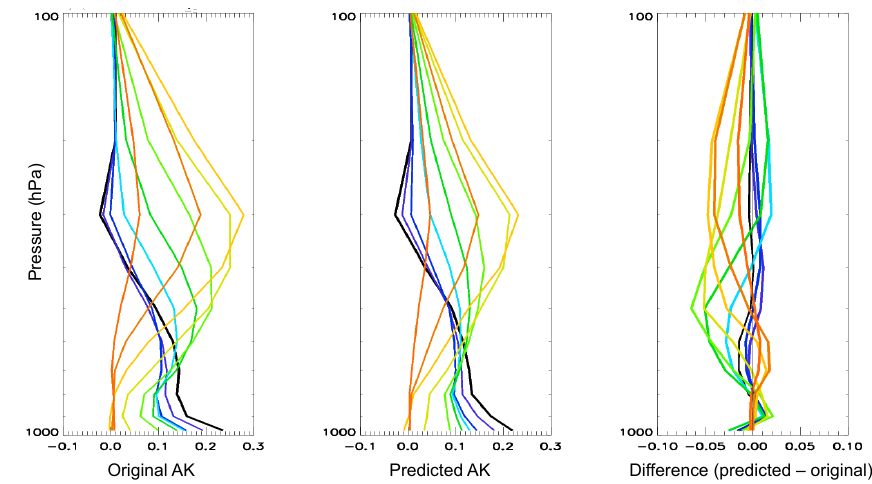
Figure 10. Example of original MOPITT test case AK and corresponding predicted AK using the results of the MR prediction shown in Fig. 9 to reconstruct the predicted AK. Differences between predicted and original AKs are shown on the right.